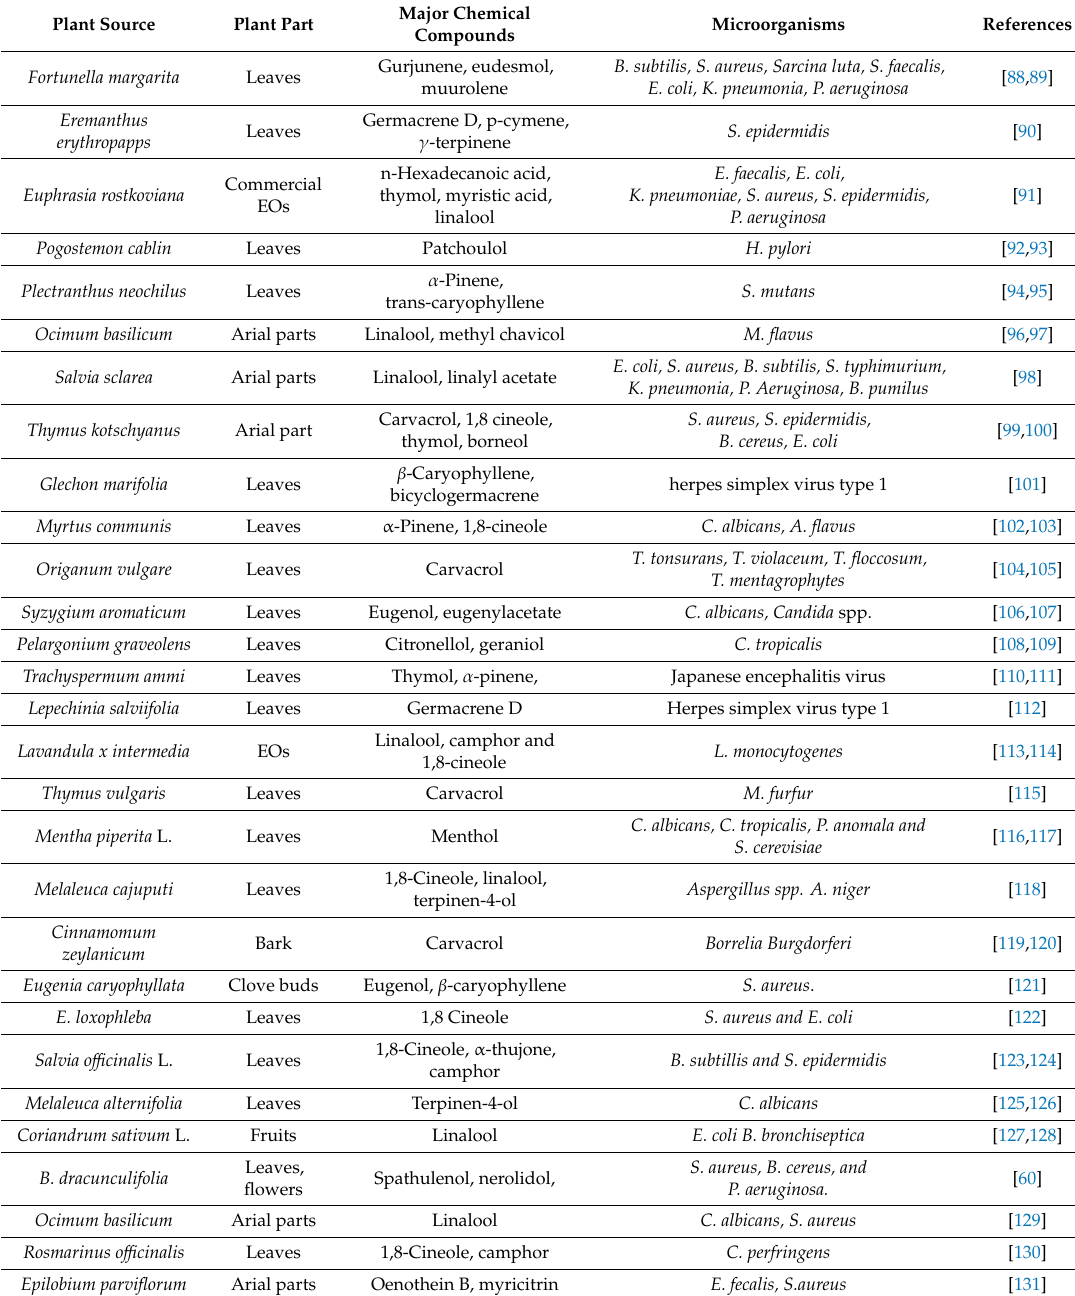
Table 2. Major chemical composition of various EOs and their antimicrobial activity